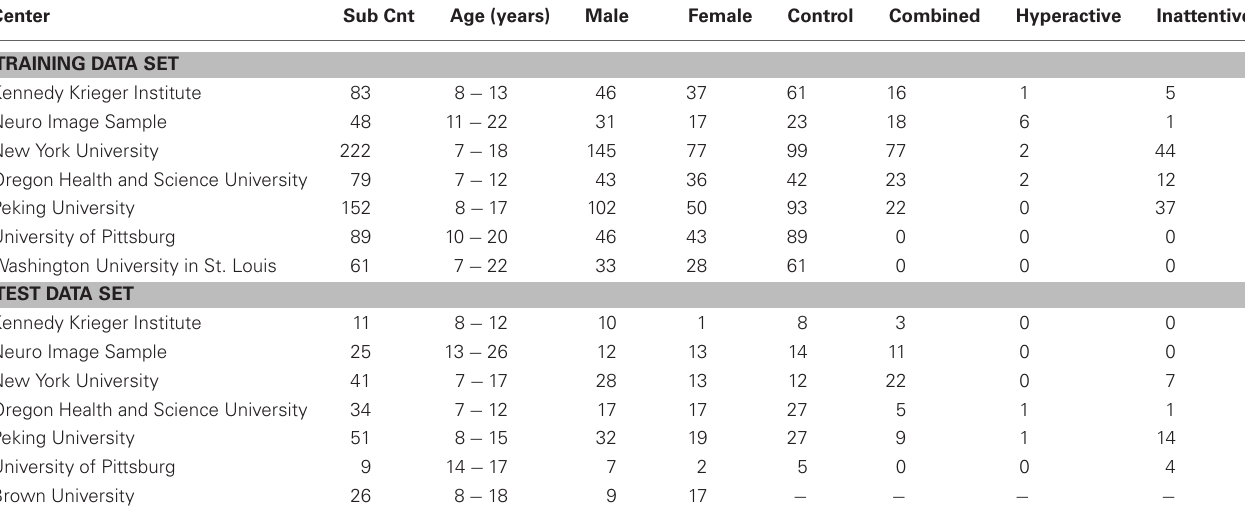
Table 1 | Summary of the data set released for ADHD-200 competition.